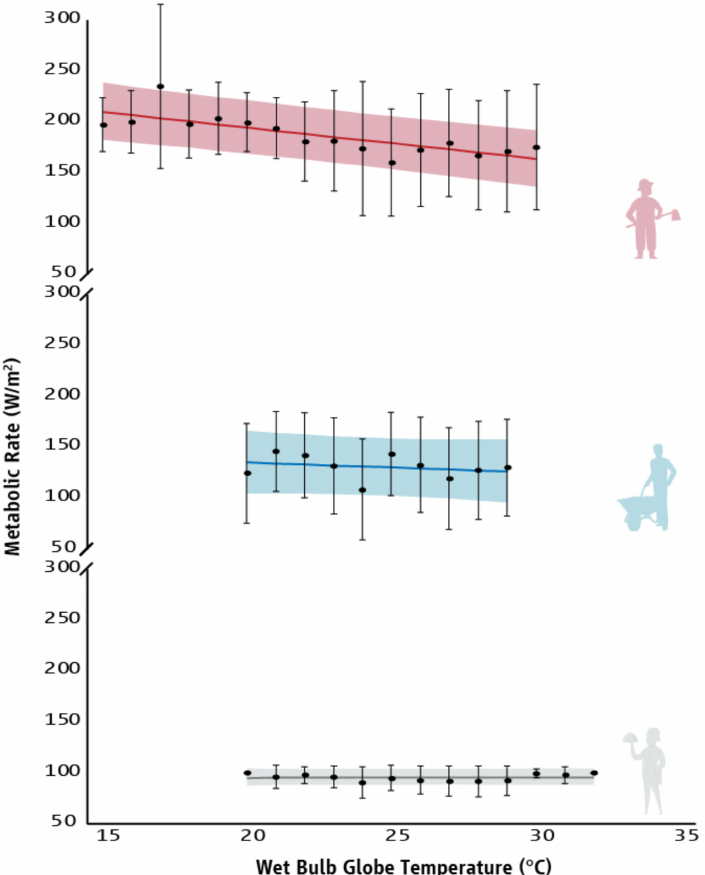
Figure 4. Relationship between Wet-Bulb Globe Temperature and the metabolic rate/work intensity (average ± SD) of people who work in agriculture (red), construction (blue), and tourism (grey) sectors. Lines represent the slope of the predicted relationship between Wet-Bulb Globe Temperature and the metabolic rate/work intensity of workers. Shadings correspond to the 95% prediction intervals of the